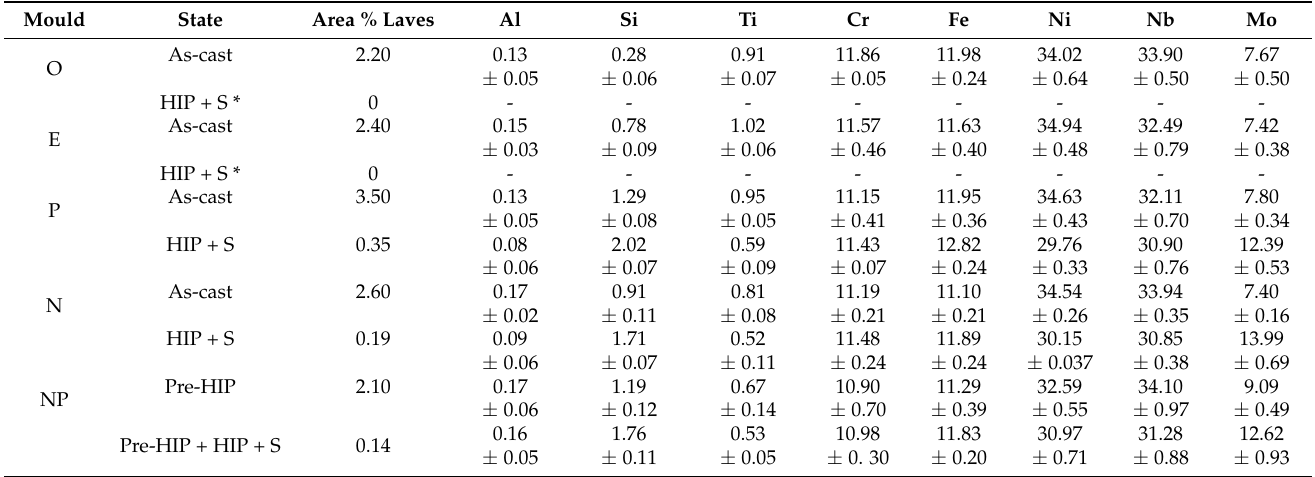
Table 2. Area percentage and chemical composition of Laves phases (in wt %) as-cast and after heat treatment obtained by / EDX) analysis (* Laves phase was not detected).